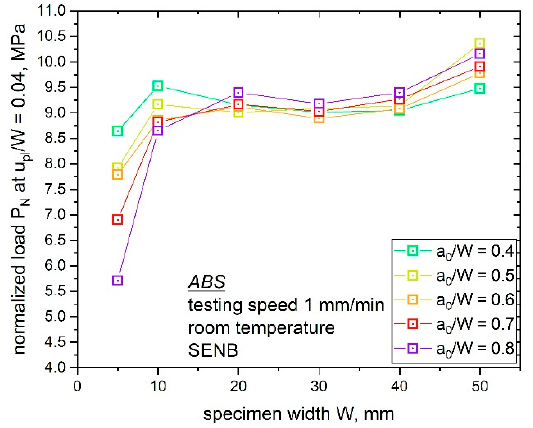
Figure 10. P N at a fixed u pl /W ratio of 0.04 for every bN specimen size examined (W of 5, 10, 20, 30, 40 and 50 mm) with varying a 0 /W ratios (0.4 to